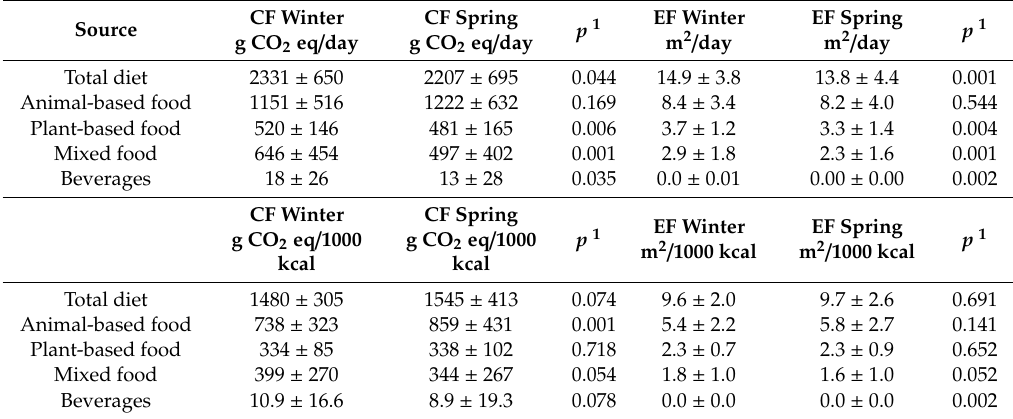
Table 2. Total and food-source carbon footprint (CF) and ecological footprint (EF) by seasons per day and by seasons per day per 1000 kcal of total